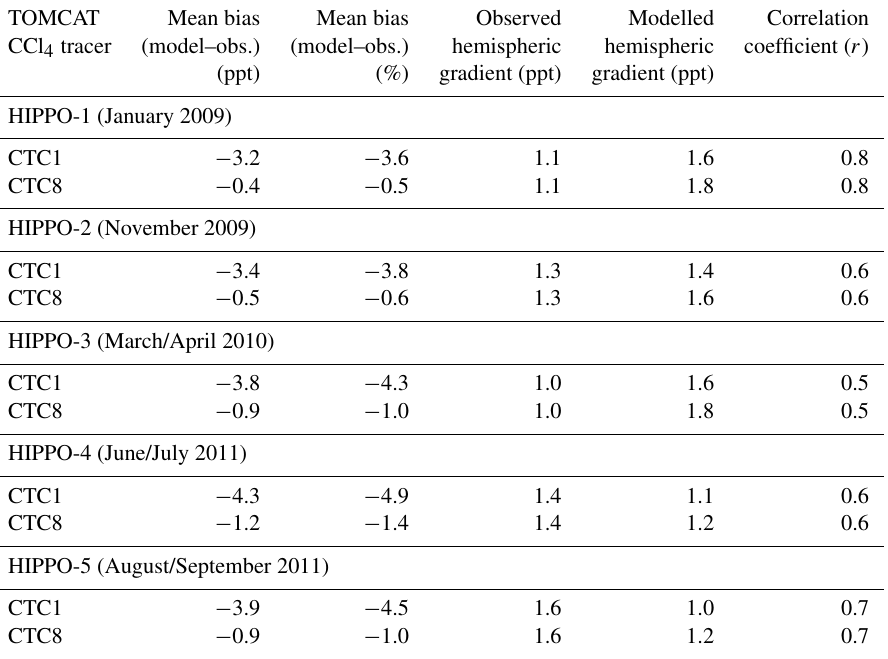
Table 3. Summary of model–measurement comparisons for boundary layer (surface–1.5km) CCl 4 observations during HIPPO aircraft missions.